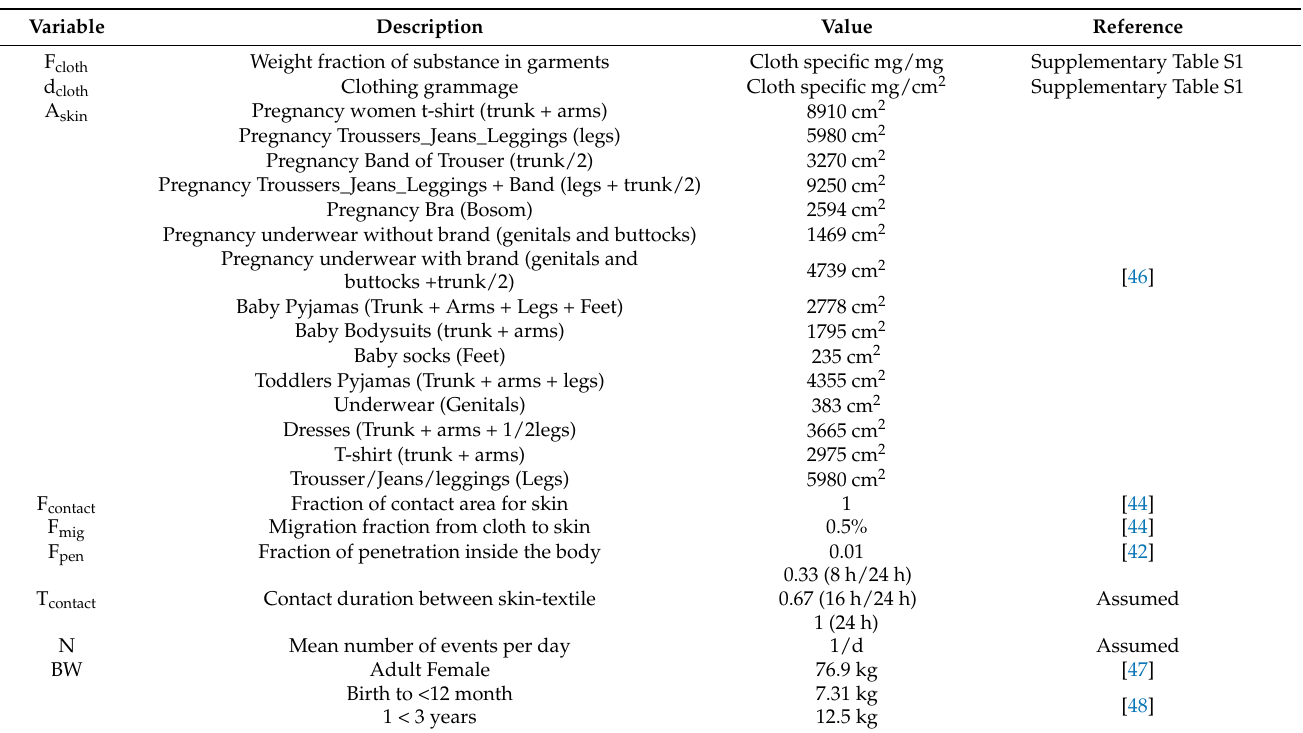
Table 1. Parameters used to assess dermal